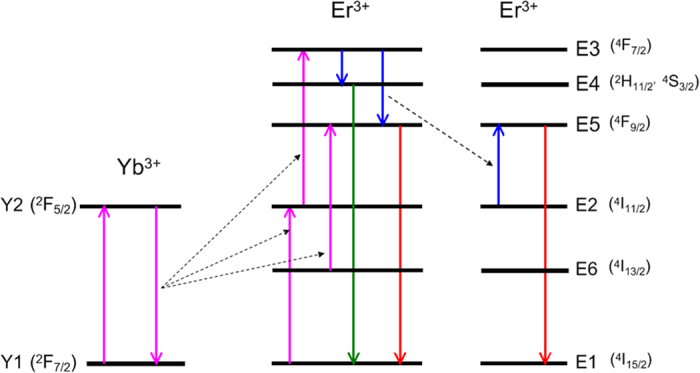
The energy level diagram for rate equation analysis.The simplified Yb3+-Er3+ UC system in Ba5Gd8Zn4O21:Yb3+, Er3+.